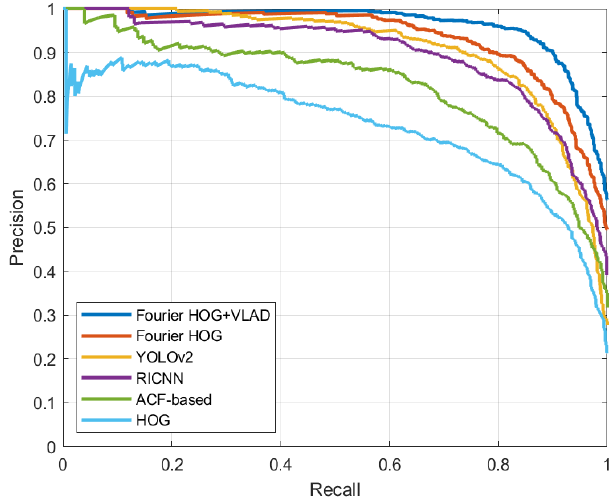
Figure 10. The PR curves of different methods on the RSOD dataset. Table 3. The performance comparisons of different methods on the RSOD